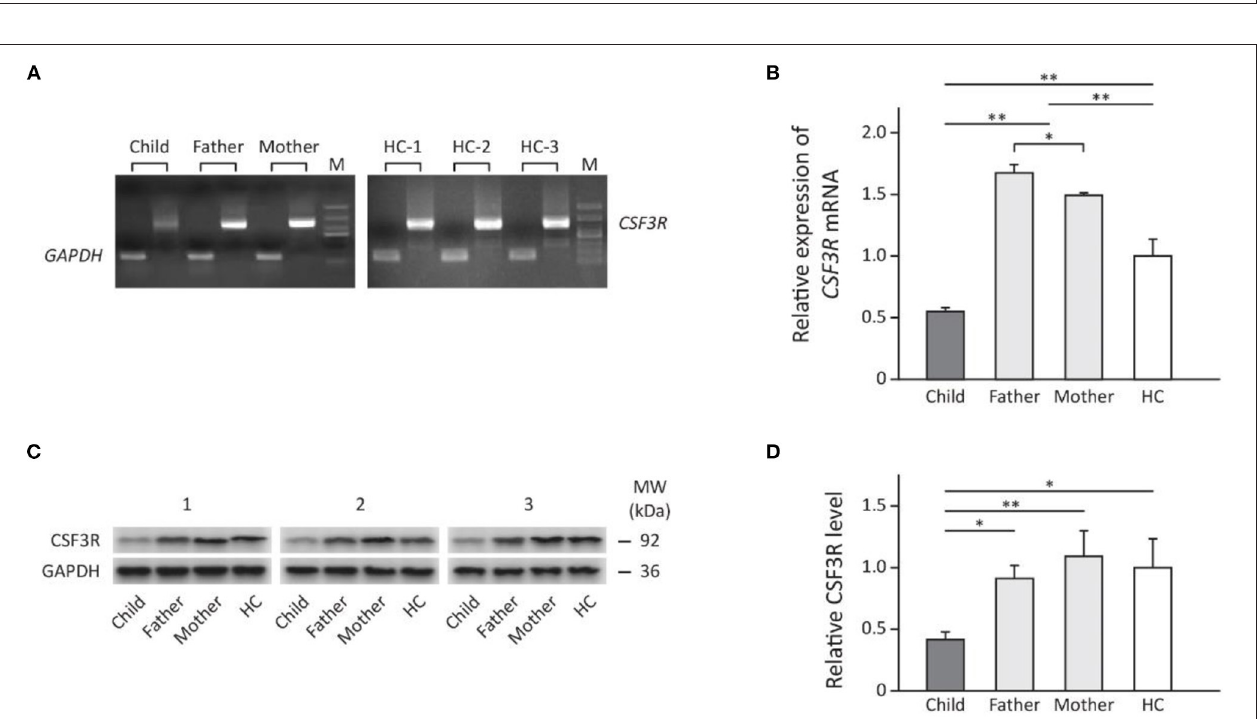
FIGURE 2 | The patient’s treatment using rhG-CSF (black triangle) and rhGM-CSF (black arrows indicate treatment initiation and injections before regular treatment). Closed dot with asterisk suggests infection. ANC, absolute neutrophil count; rhG-CSF, recombinant human granulocyte colony-stimulating factor; rhGM-CSF, recombinant human granulocyte macrophage colony-stimulating factor.